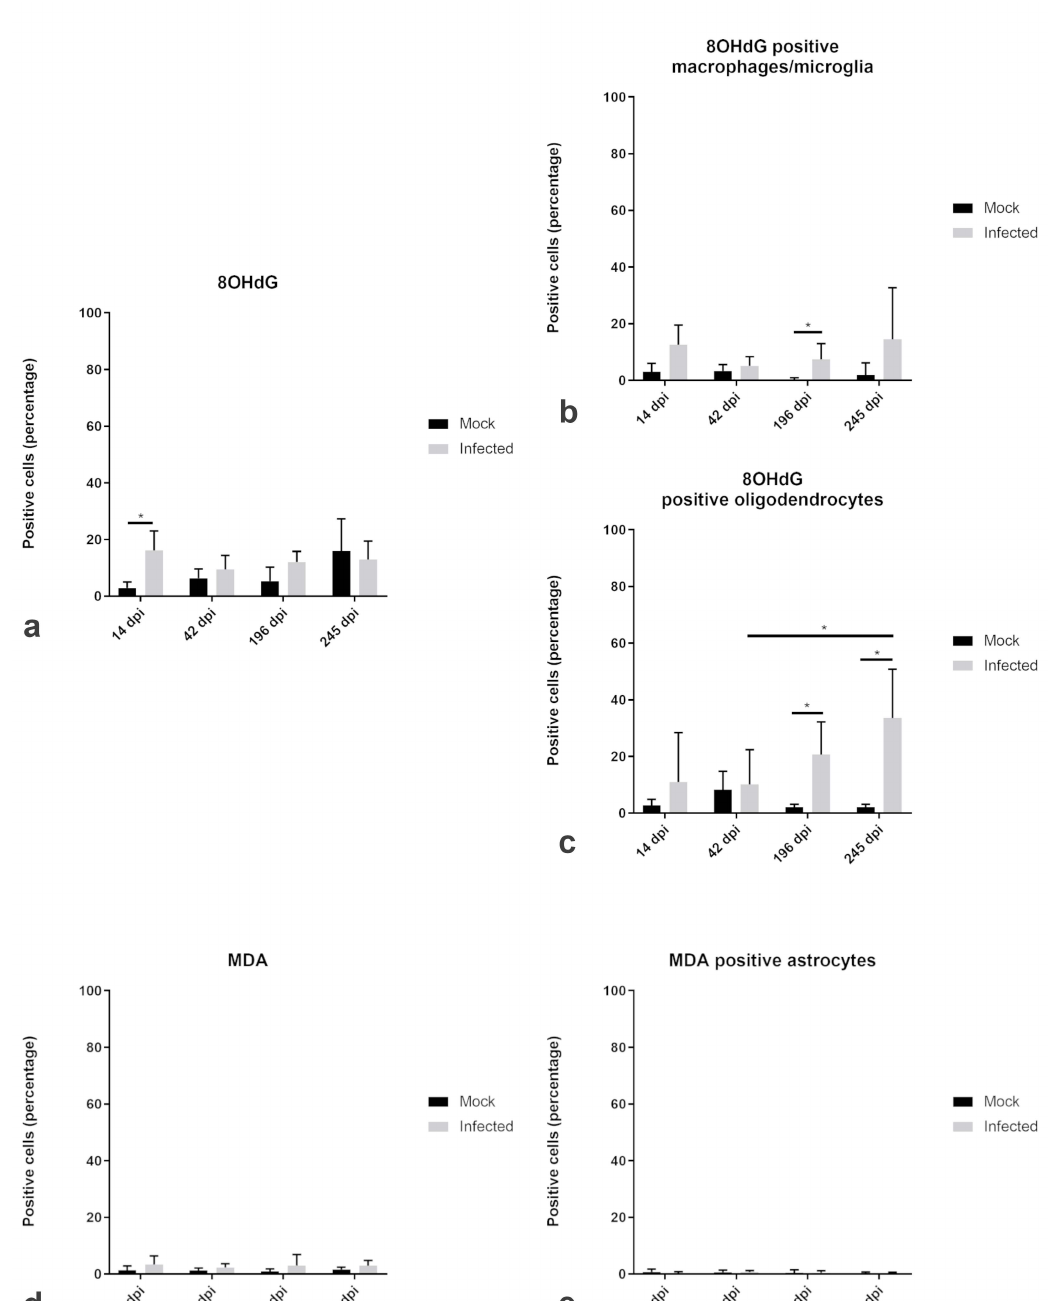
Figure 6. Relative changes in the proportions of cells immunopositive for reactive oxygen species (ROS) products and colocalization with astrocytes, oligodendrocytes, and microglia / macrophages in the white matter of spinal cord of TMEV-DL. The box plots show percentages of positive cells for ROS products (8-OHdG ( a ) and MDA ( d )) and the percentage of double-positive ( b ) macrophages / microglia, ( c ) oligodendrocytes and ( e ) astrocytes at day 14, 42, 196, and 245 dpi compared to mock animals. Significant di ff erences between the groups as revealed by the Kruskal–Wallis test with independent pairwise post-hoc Mann–Whitney U-test are marked with an asterisk (* p ≤